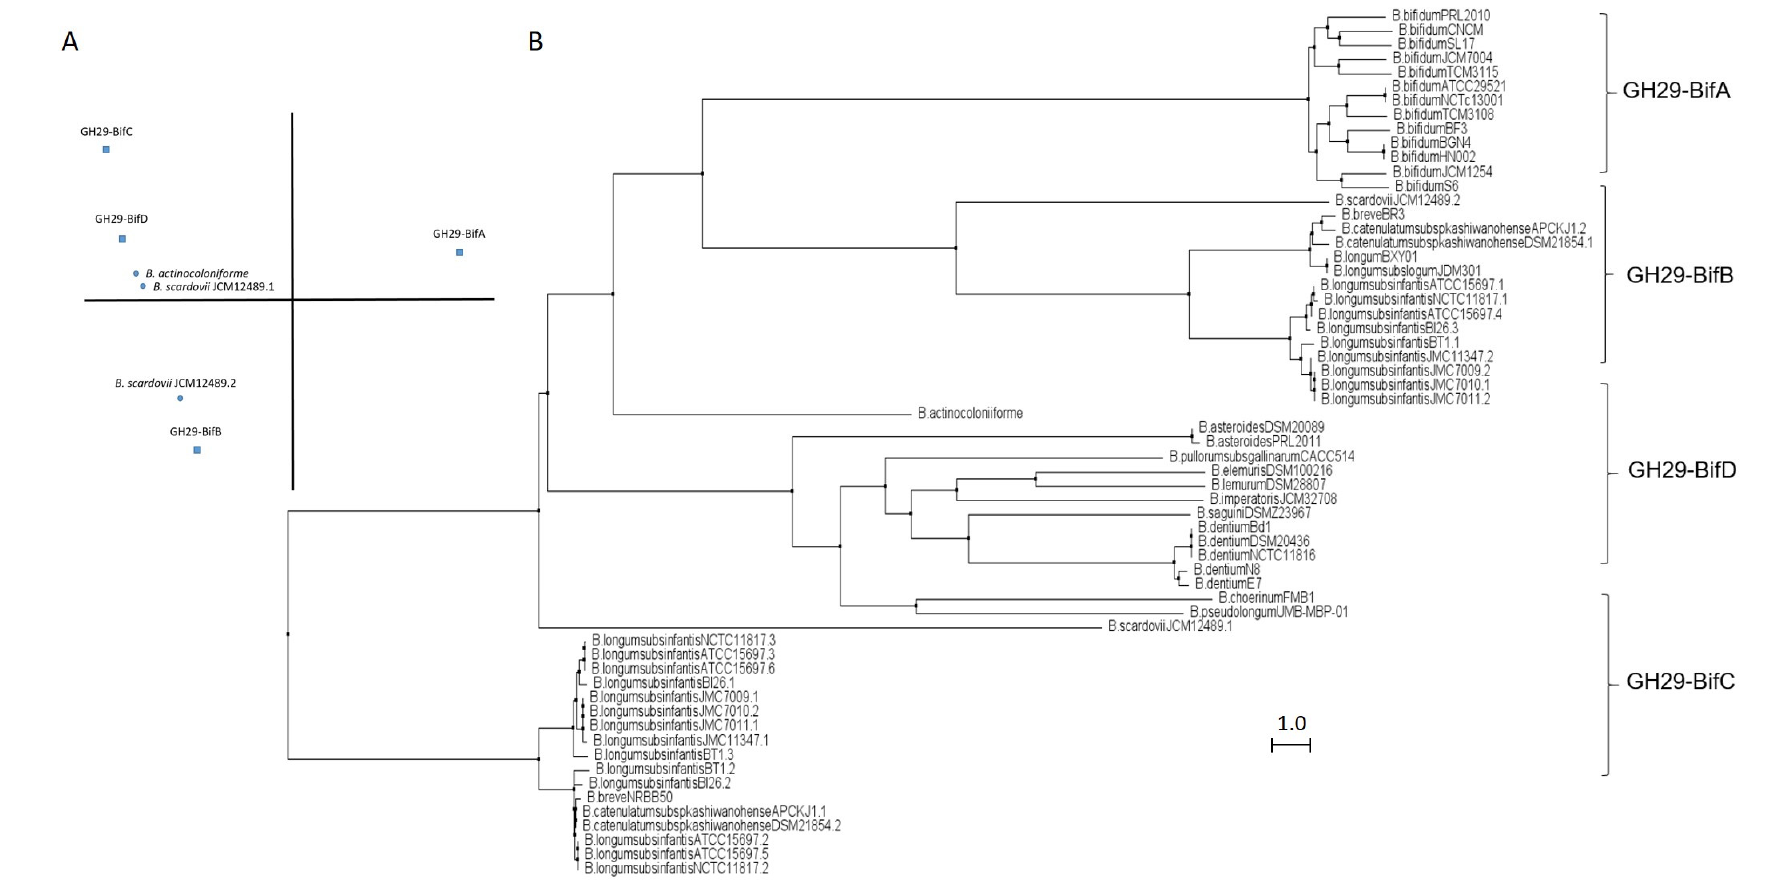
Figure 2. Phylogenetic analysis of bifidobacterial GH29 fucosidases. PCA ( A ) and cladogram tree ( B ) distributions of bifidobacterial GH29 fucosidase sequences listed in CAZy, released from Jalview 2.11.1.4 software using the neighbor-joining method.